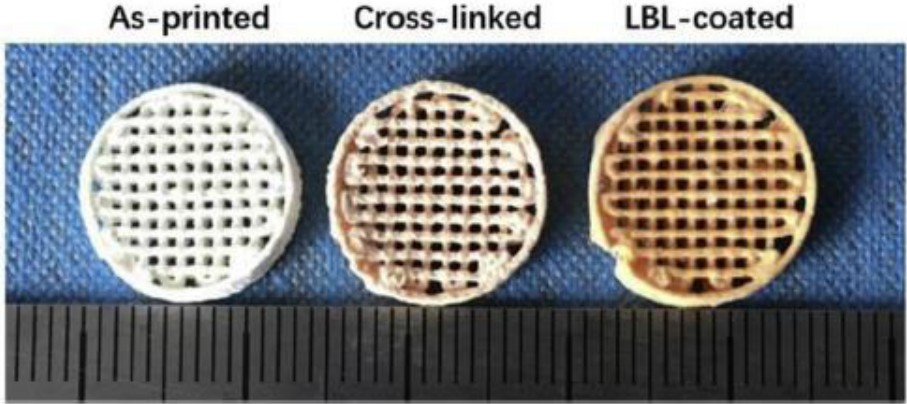
Figure 4. Photographs of an as-printed, cross-linked and coated scaffold (from Chen et al., [37], with permission).